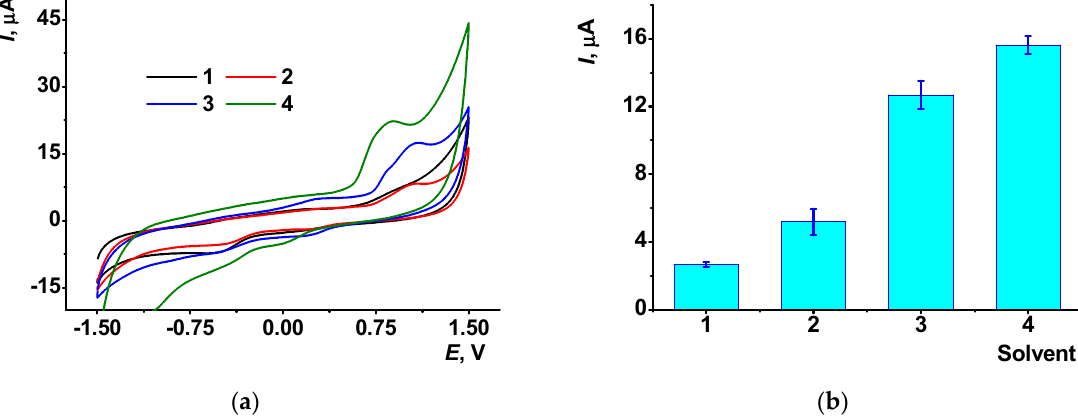
Figure 4. ( a ) Cyclic voltammograms recorded on the GCE covered with CB/AY (1:1 mixture, chitosan, 2 µL per electrode) after 10 min incubation of the electrode in organic solvent. ( b ) The AY anodic peak currents recorded after the contact of the GCE covered with 1:1 mixture of CB/AY in chitosan with DMF (1), ethanol (2), chloroform (3) and phosphate buffer, pH = 4.0 (4). Average from three repetitions with individual